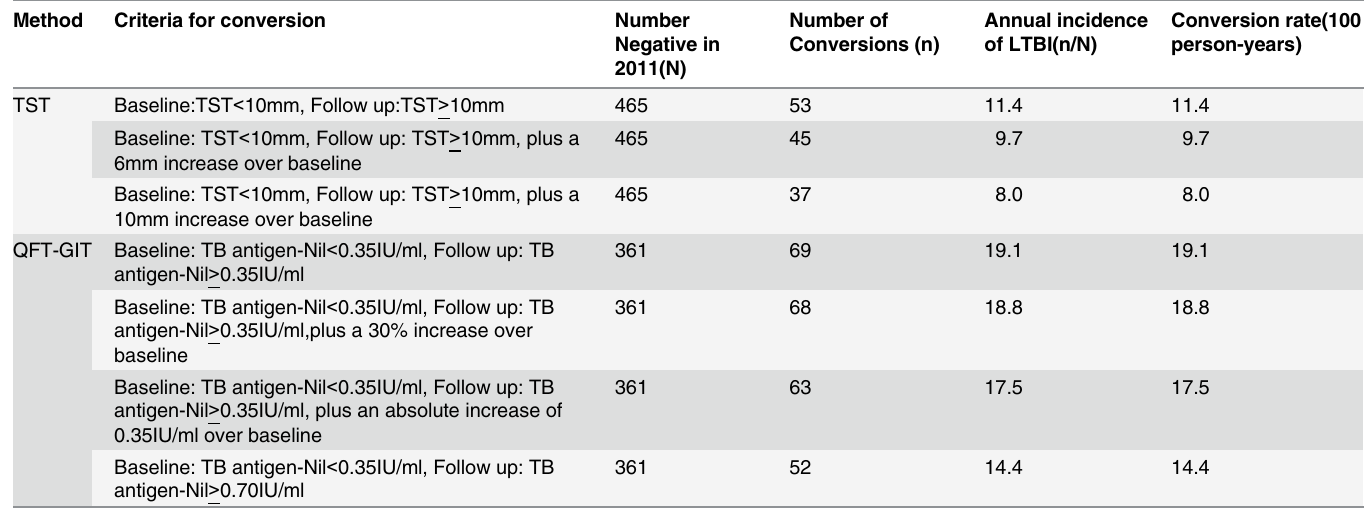
Table 4. The incidence of LTBI detected by TST and QFT-GIT among village doctors.